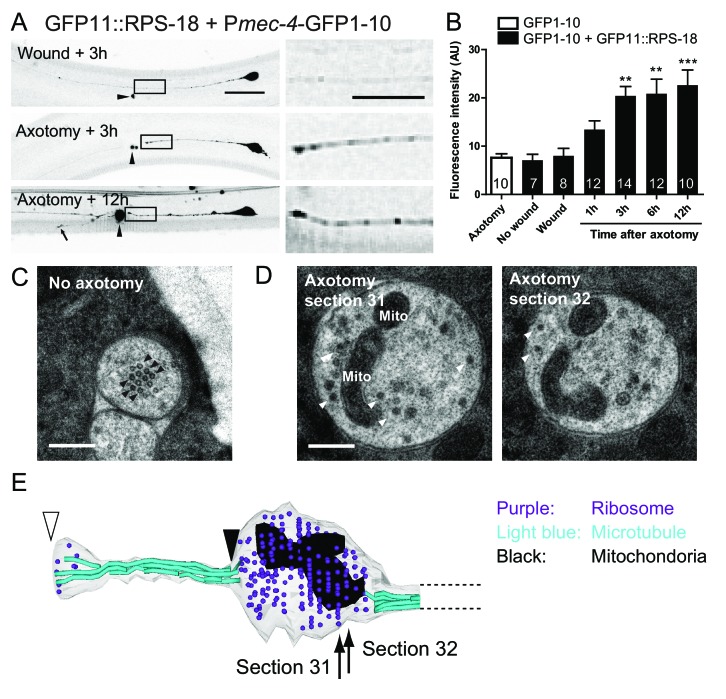
Ribosomes accumulate at the tip of proximal axons after axon injury in mechanosensory neurons.(A) Pmec-4-RIBOS three or twelve hours after axon injury or wounding. For negative control, worms were wounded by laser without damaging the axon. Right panels are magnified images of the black square regions. Arrowheads indicate laser illumination site. An arrow indicates the tip of the regrowing axon. Scale bar: 20 µm; 10 µm in the magnified image. (B) Quantification of fluorescent intensity at the proximal axons indicated by boxes in (A). Numbers of worms were shown in the bars. Statistics: One-way ANOVA, **p<0.01, ***p<0.001, compared to the wounded condition. (C) Electron micrograph of PLM axon without axon injury. The uninjured PLM on the right side was used as a control from the same worm as in (D). Black arrowheads: microtubules. Scale bar: 200 nm. (D and E) The tip of the PLM axon on the left side six hours after axon injury. (D) Two serial electron micrographs corresponding to two sections in (E). White arrowheads: monosome-like electron dense particles; Mito: mitochondria. Scale bar: 200 nm. (E) Serial reconstruction EM, corresponding to forty-two sections with 50 nm thickness (2.1 µm in length). Black arrowhead indicates the presumable cutting site and white arrowhead the regrowing tip. Ribosome (purple dots) and mitochondria (black) accumulated around the cutting site, which lacks microtubules (light-blue lines).